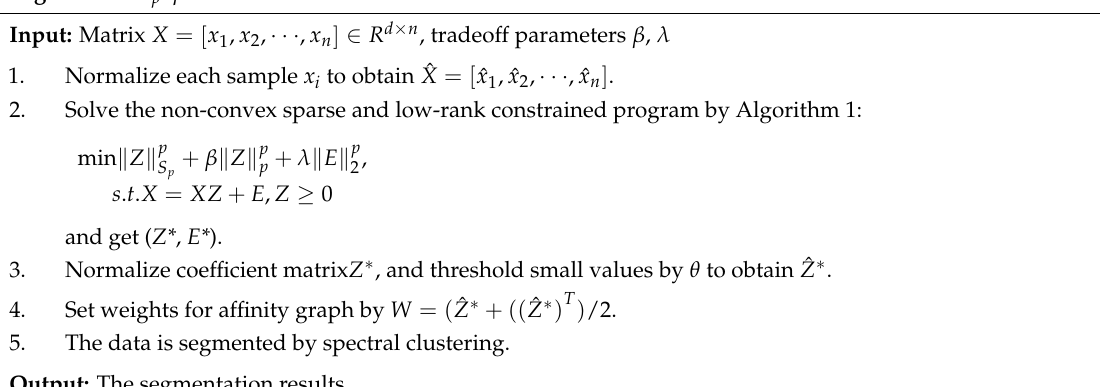
Algorithm 2. l p S p